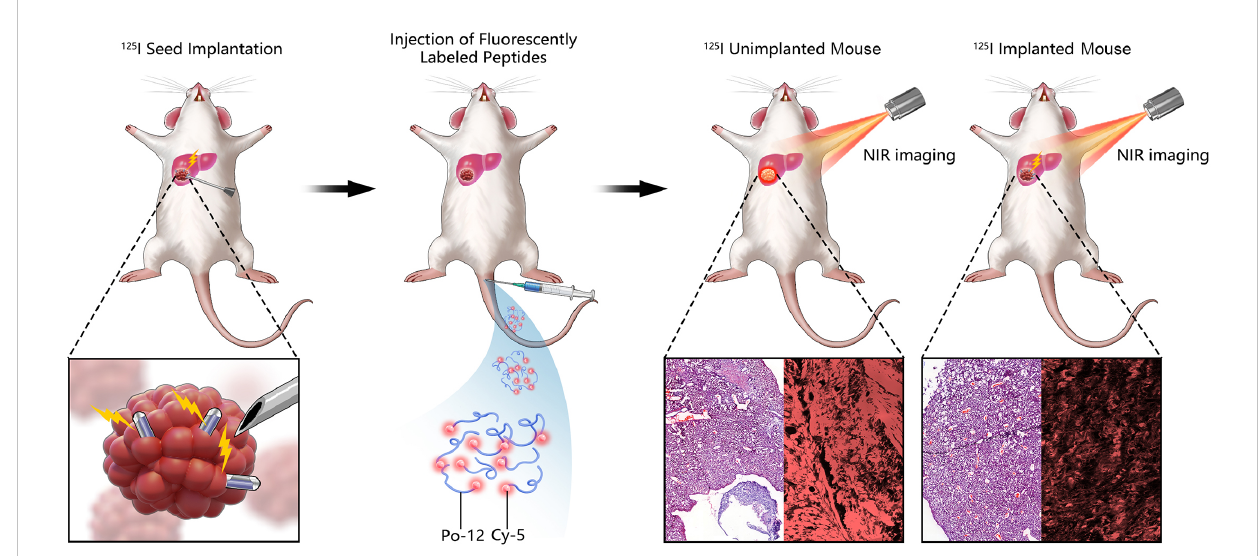
FIGURE 1 Diagram showing the general scheme for using the TIGIT probe in near-infrared fl uorescence (NIRF)-guided 125 I seed brachytherapy in orthotopic HCC. 125 I seed was used to implanted into orthotopic tumor for radiation. Po-12 conjugated Cy5 targeting TIGIT was administrated by tail vein. Change of TIGIT expression was detected by NIR